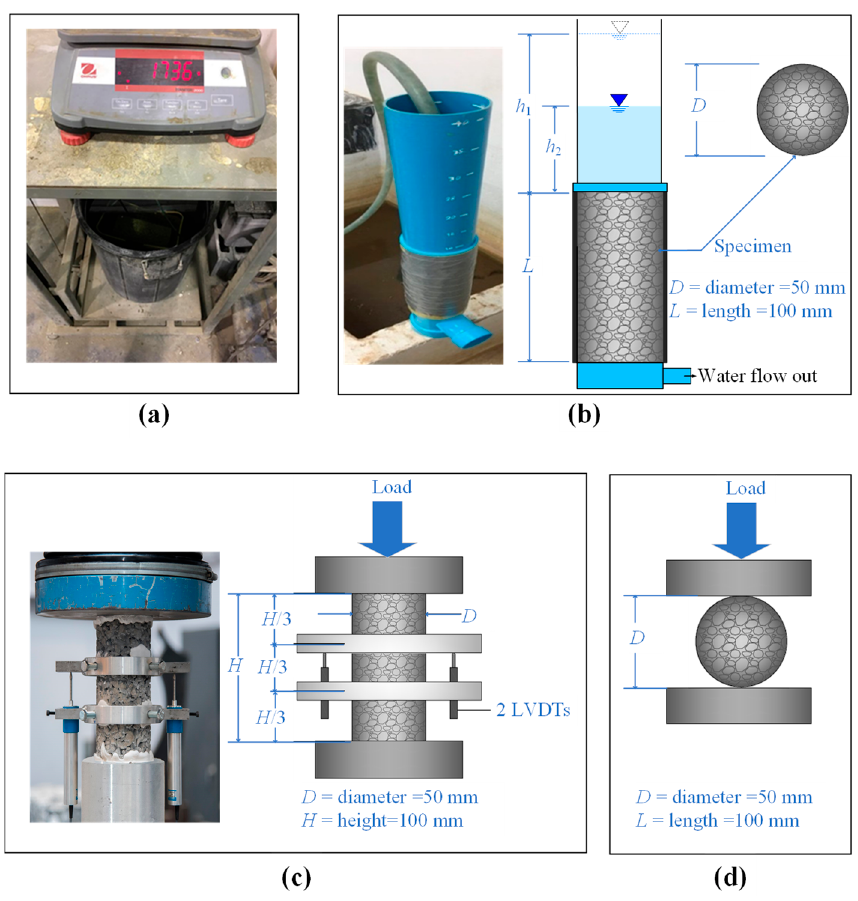
Figure 6. Test apparatus for determining ( a ) submerged density, ( b ) permeability coefficient, ( c ) unconfined compressive strength, and ( d ) splitting tensile strength.